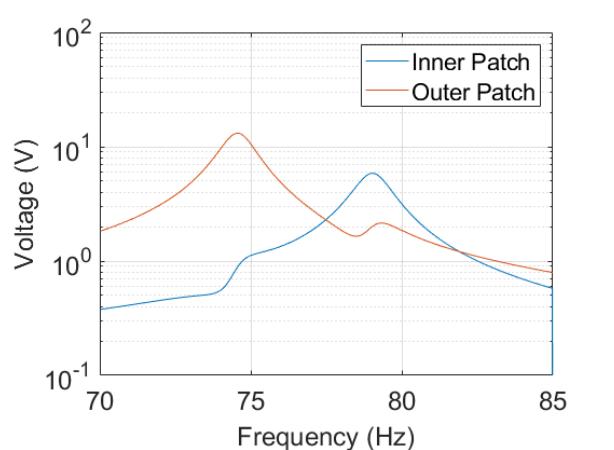
Figure 8. Open- circuit voltage output of the structure obtained through harmonic analysis. The structure is excited with 0.2 g at its fixed end. The damping is set to